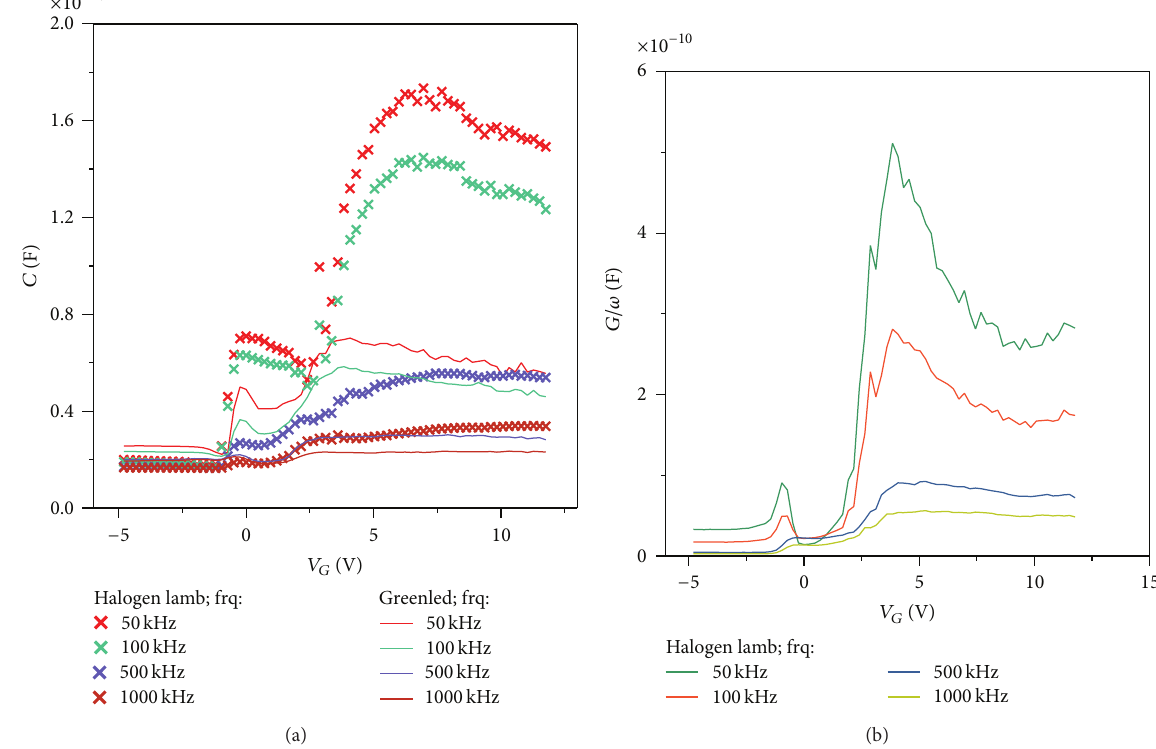
Figure 5: (a) Capacitance and (b) conductance as a function of bias voltage on Ag/TiO 2 /p-c-Si structure under exposure light.